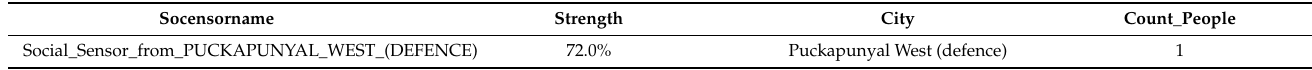
Table 10. Instances of social sensor discussions on gusts.